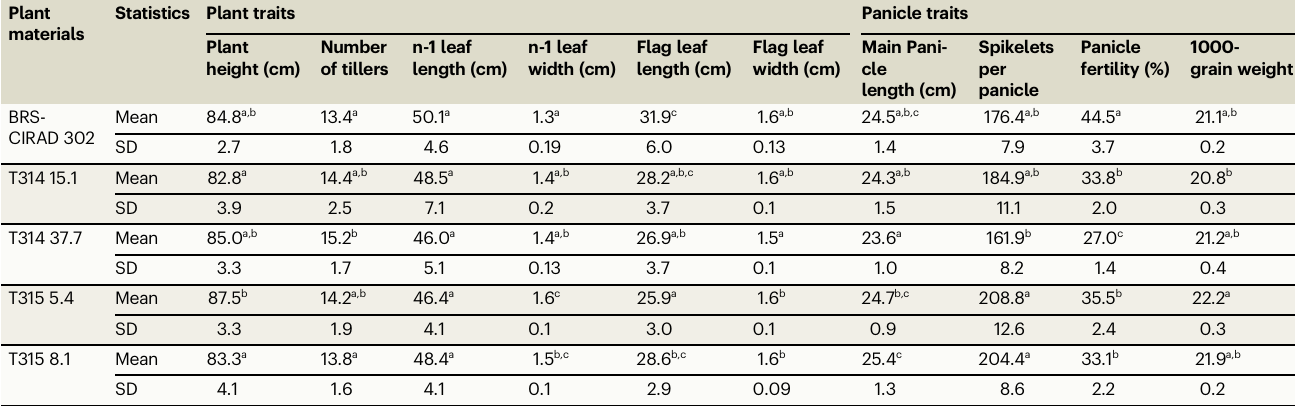
At least 34 T2 plantsderiving from 5 T1 plants per eventweregrown alongsidecontrolBRS-CIRAD 302F1 hybrid plants ( n =15) under controlled greenhouse conditions.Details are provided in SupplementaryTable7.Foralltraitsbutpaniclefertility,differentletters(a,b,c)pointsigni fi cantdifferencesusinganon-parametricKruskal – Wallistestwithan α -riskof0.05,followedbyapairwise comparisonaccordingtoDunn ’ stest.Forpaniclefertility,differentletters(a,b,c)pointsigni fi cantdifferencesfollowingaDuncan ’ smultiplerangetestwitha95%con fi denceinterval.Sourcedataare provided as a Source Data fi le. SD